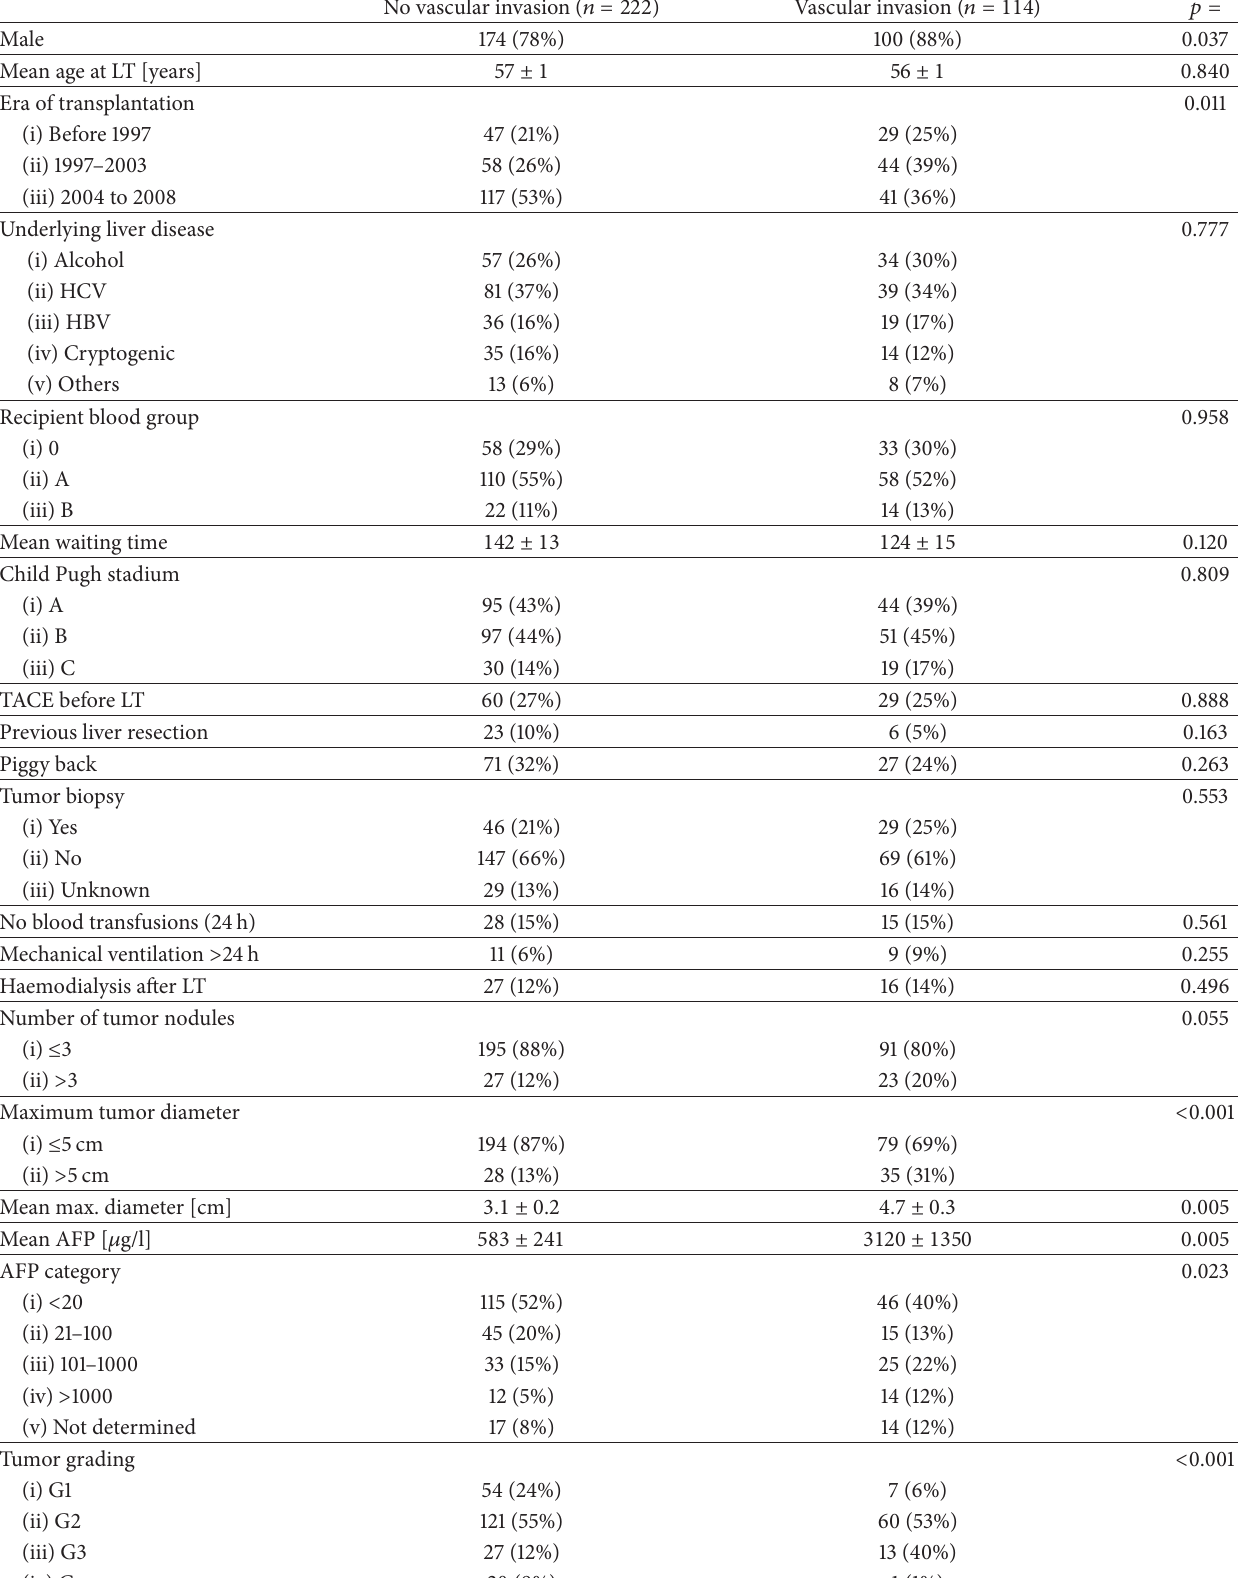
Table 1: Comparison of patient and tumor characteristics in the subgroups with and without microvascular